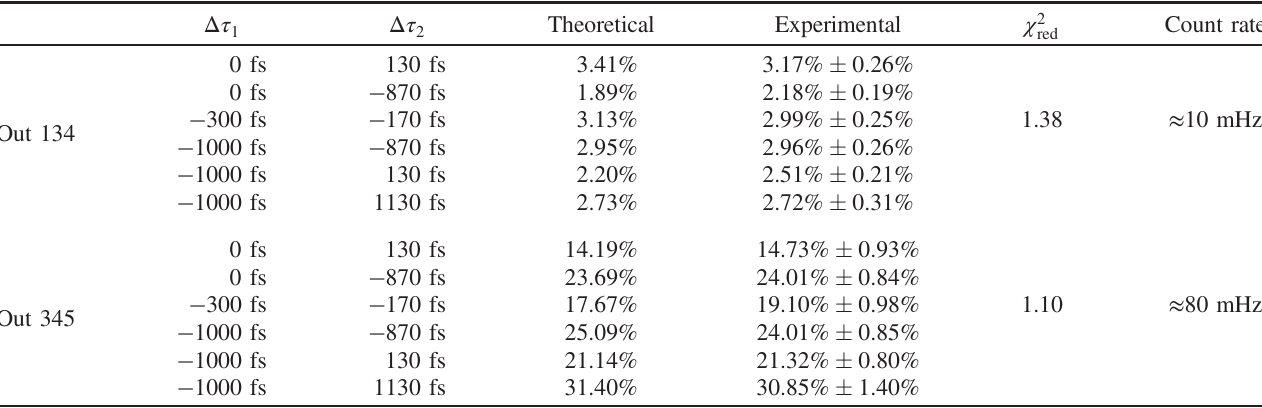
TABLE III. Data for the coincidence landscapes of Fig. 3. Three photons are injected into input ports 1, 2, and 4 of the interferometric network. They are recorded as a fourfold coincidence measurement between output modes 1, 3, and 4 and the trigger mode, labeled “ Out 134, ” and output modes 1, 3, and 4 and the trigger mode, labeled “ Out 345. ” The theoretical prediction, “ theoretical, ” for the output probability to record a certain event for a pair of temporal delays Δ τ 1 and Δ τ 2 is calculated using Eq. (A16). The experimentally acquired count rates, “ experimental, ” are normalized to unit vectors and fitted to the theoretical data resulting in a goodness of fit of χ 2 ¼ 1 . 38 and χ 2 ¼ 1 . 10 , respectively. The experimental errors are standard deviations over 19 independent measurements. red red Δ τ Δ τ 1 2